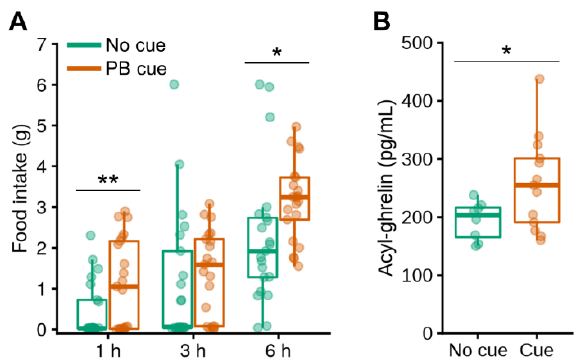
Figure 7. Olfactory detection of PB triggers release of active ghrelin in non-food-deprived PB taste-familiar rats. ( A ) Confirmation of the cue-induced overeating of chow in a new cohort of PB taste-familiar rats subjected to a cross-over design ( n = 21). Manual food intake (g) measurements after 1, 3 and 6 h post-cue introduction in the home cage. The same time points were used as for the control condition on the day before, in which spontaneous food intake was measured in the absence of the PB cue following introduction of an empty tube in the perforated ball; ( B ) levels of acyl-ghrelin (also known as active ghrelin, pg/mL) under ad libitum -fed conditions after 1 h of exposure to the olfactory PB cue ( n = 21: No cue, n = 8; PB cue, n = 13). For illustration, the thick line always corresponds to the median, boxes show first and third quartiles and whiskers represent minimum and maximum values. In ( A ), symbols indicate differences between the control and the PB cue conditions at (*) p < 0.05 or (**) p < 0.01 by paired samples t -tests; in ( B ), the symbol indicates differences between the control and the PB cue conditions at (*) p < 0.05 by one-way ANOVA. PB; peanut